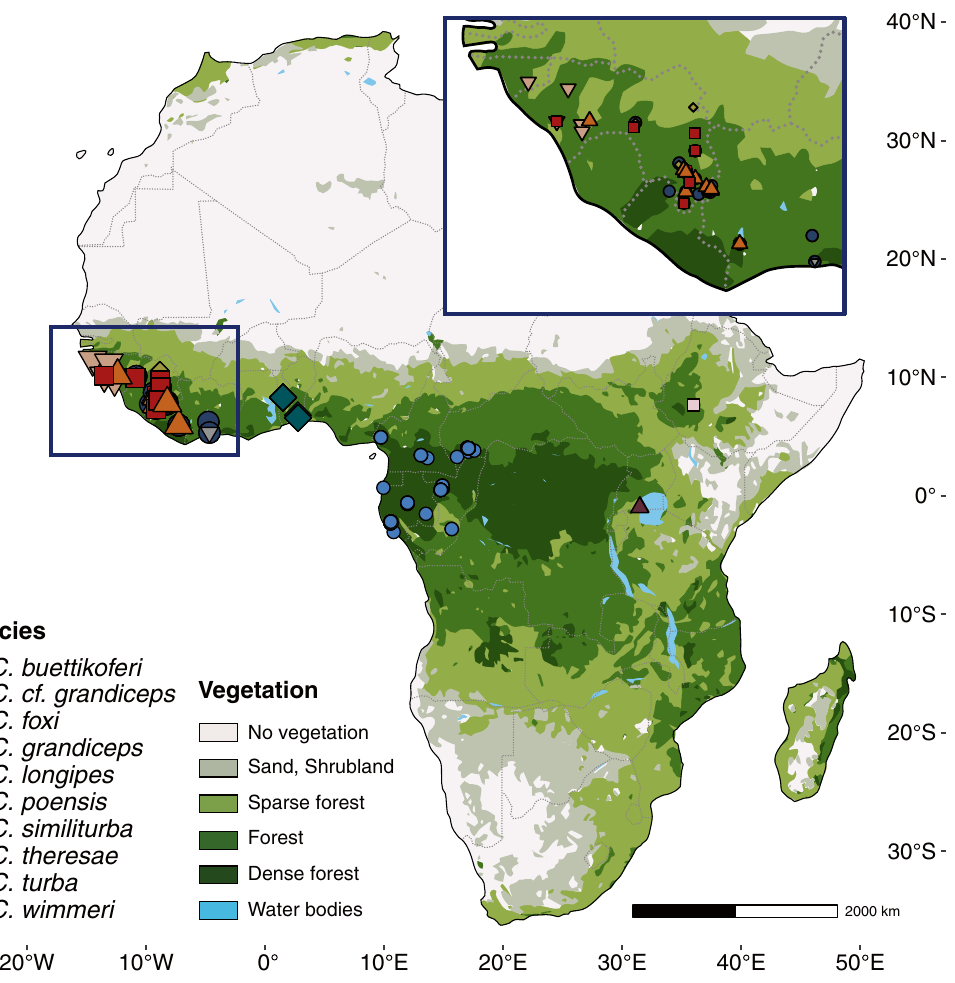
Figure 1. Specimen distribution map. Scaled map of Africa representing all specimens included in the morphometric study plotted over a schematic depiction of African biomes (vectorized rendition adapted from a google vegetation map, 2020, drawn with Procreate 5.2.6—https:// procr eate. art/—and vectorized using Adobe Illustrator 24.0.2—https:// www. adobe. com/ produ cts/ illus trator. html). Species are depicted using colors and